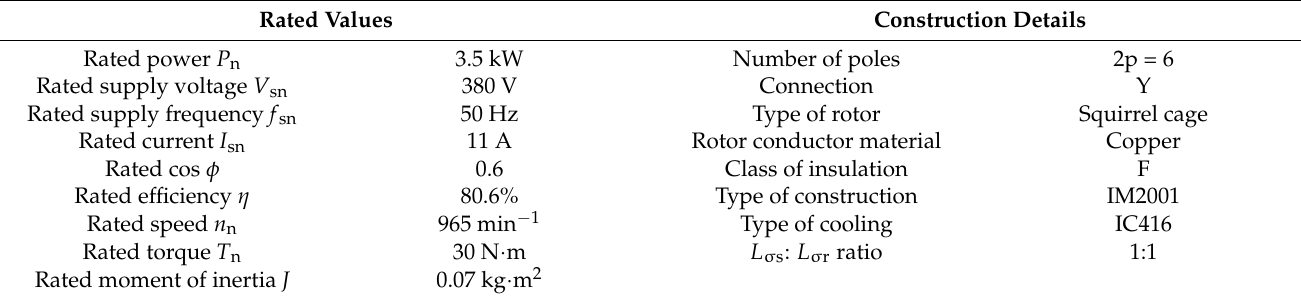
Table 2. Values of parameters of tested machine used for calculations obtained by standard tests specified in [13].